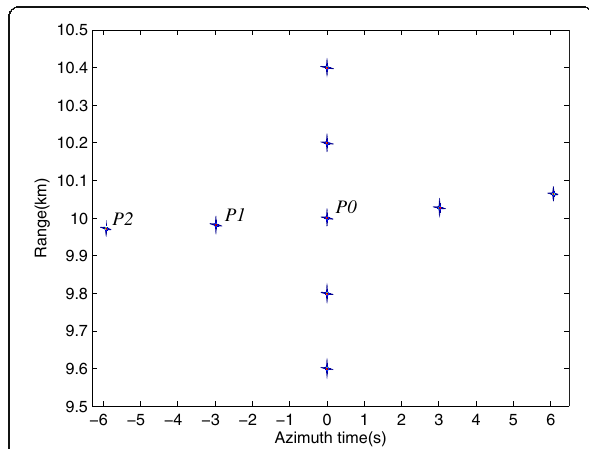
Fig. 15 Entire focused images by the proposed algorithm in case